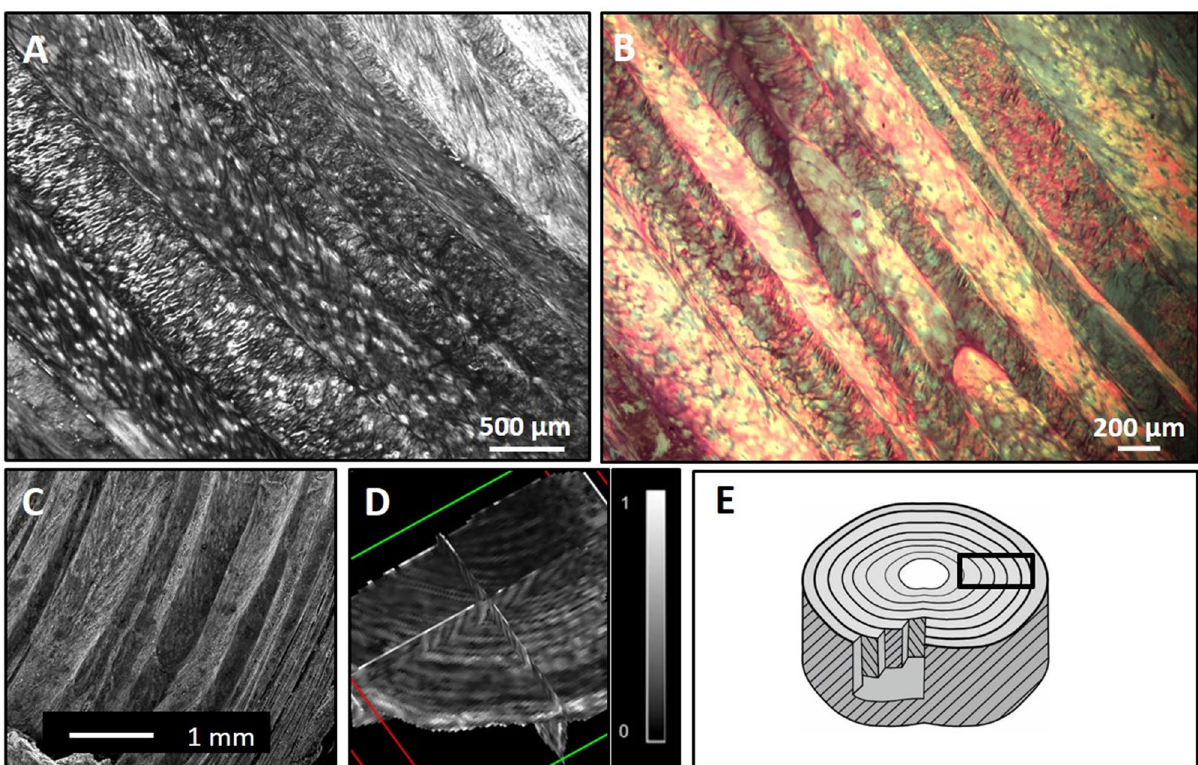
Figure 1. A portion of the outer AF and its structure. Two-dimensional high-resolution histological images of the AF (axial section) using light microscopy ( A , B ): The different orientations of the fiber tracts in each lamella are clearly seen in ( A ), whereas ( B ) (Masson Trichrome stain) presents the complex structure of the AF. The 2D scanning microscope image yielded a consistent arrangement ( C ). DTI generated 3D FA data where distinct concentric lamellae rings are seen (as in the histological sections), since they are associated with anisotropic water diffusion ( D ). The scheme ( E ) shows lamellae layers with alternating orientation fibers surrounding the nucleus pulposus (center).